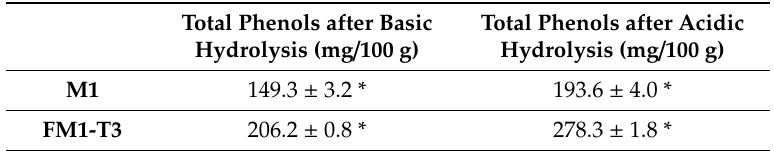
Table 3. Total phenolic content estimated by HPLC-DAD analysis after basic and acidic hydrolysis in the unfermented (M1) and fermented (FM1-T3)